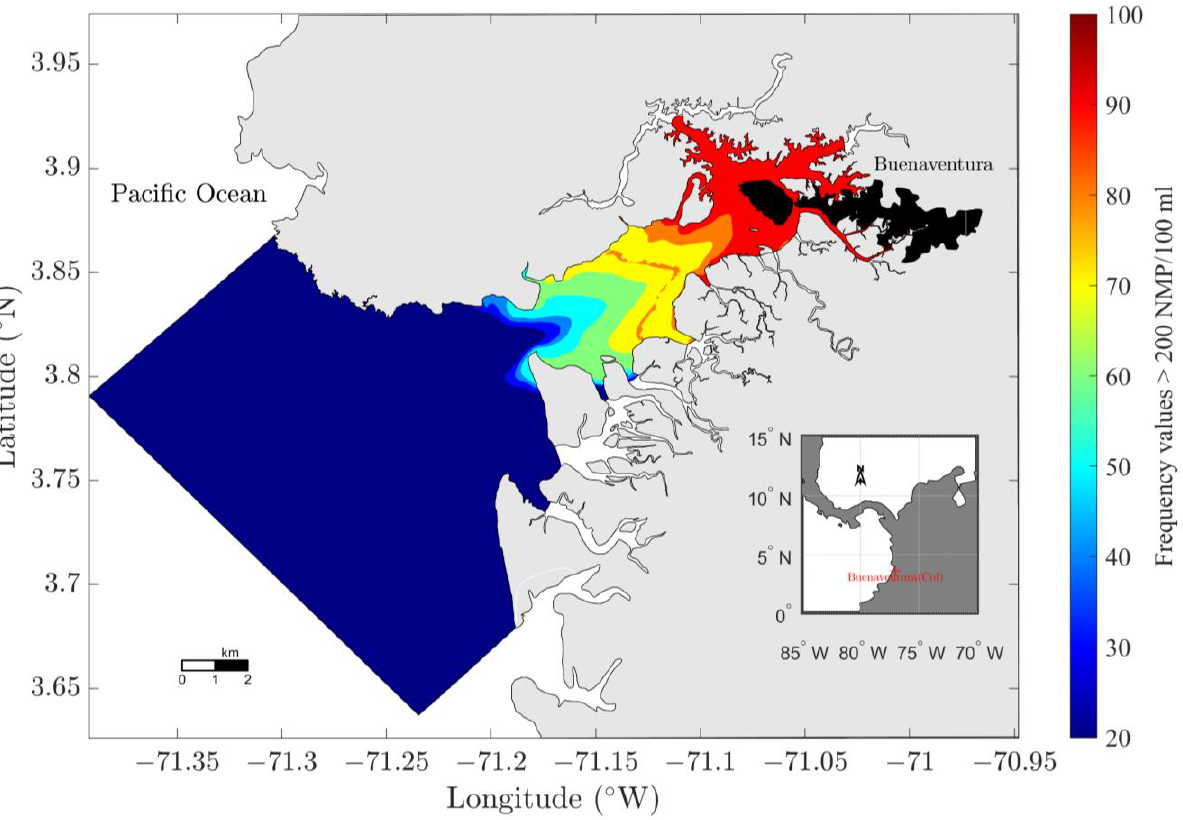
Figure 12. Frequency of areas affected by concentrations higher than 200 MPN/100 mL in the water column scenario